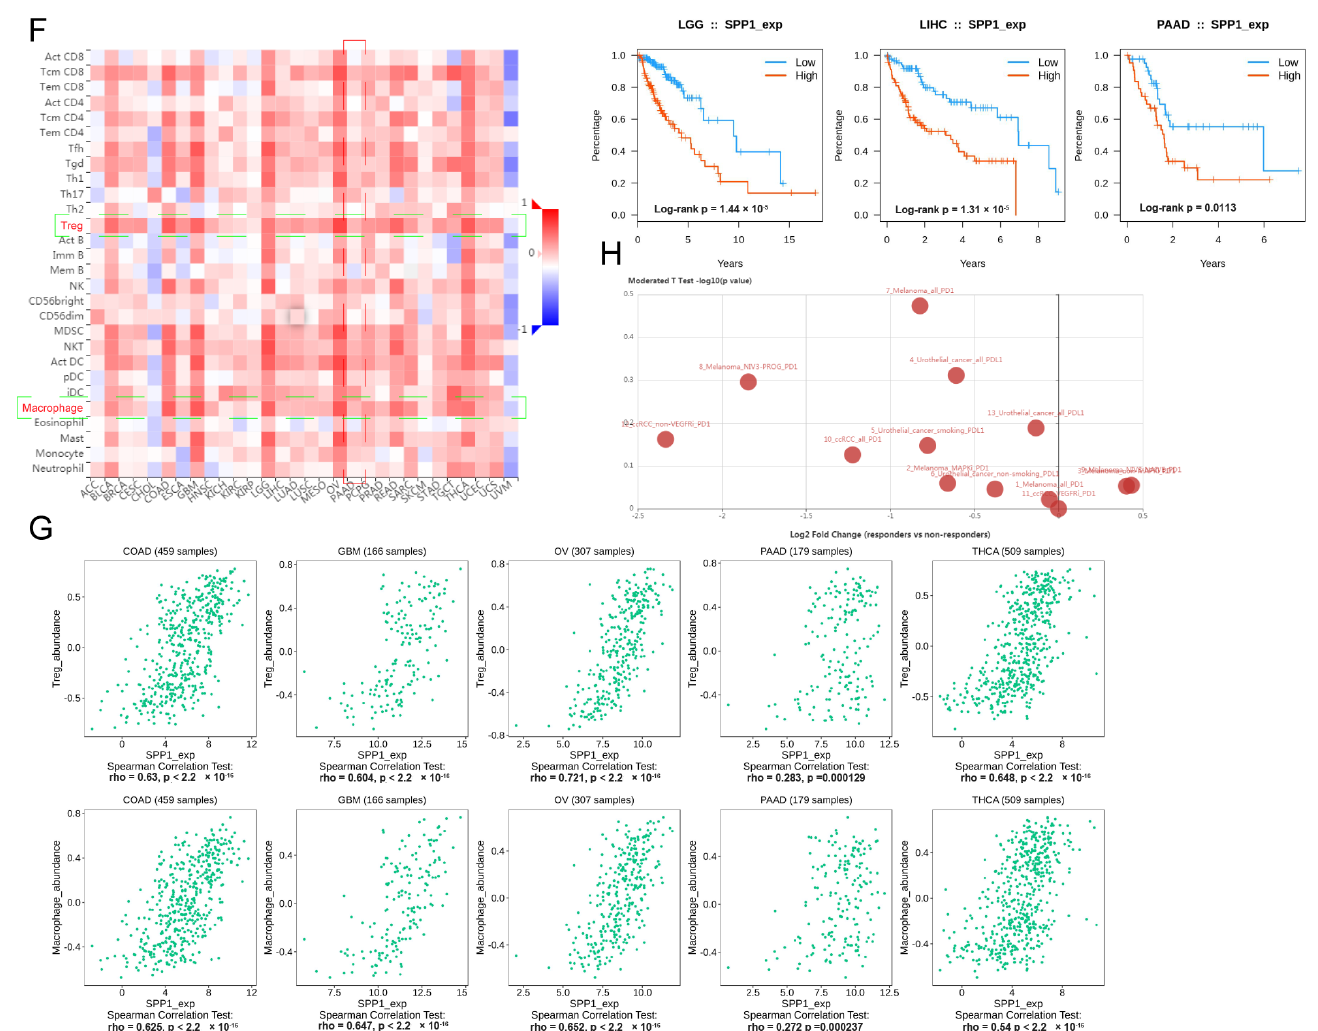
Figure 3. The landscape of key signature–SPP1. ( A ) The different immune scores between high- and low-risk groups; ( B ) KM curve showing the OS of patients between the high- and low-immune score groups; ( C ) the immune cell composition of high- and low-risk groups are shown in box plots. *, **** represent p < 0.05 and 0.0001; ( D ) the expression level of SPP1 among various tumors (red bars represent a tumor and black bars represent normal tissues); ( E ) KM curves showing the prognostic value of SPP1 among various tumors; ( F ) the heatmap showing the correlation of the expression of SPP1 and immune cell subpopulations, targeted cell types were labeled with green frame; ( G ) the scatter plots showing the relationship between the expression of SPP1 and Tregs and macrophages among various tumors; ( H ) the expression of SPP1 between responders and non-responders in various checkpoint blockade therapy